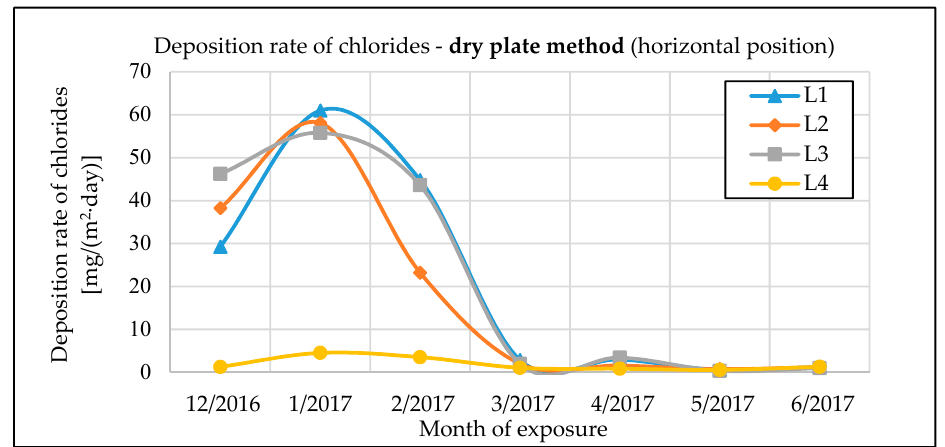
Figure 9. The deposition rates of chlorides determined by the wet candle method.